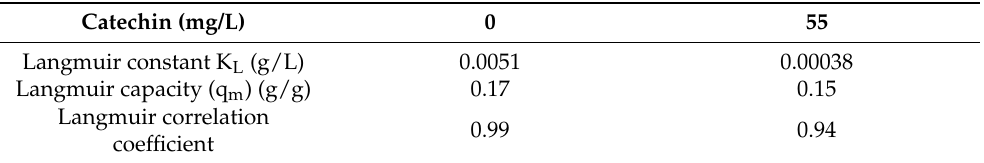
Table 5. Effect of catechin on protein adsorption. Protein concentration was monitored by using the Bradford protein assay and UV-Vis spectrometry at 595 nm. The Langmuir isotherm parameters in the presence of catechin are estimated for low protein equilibrium concentrations.